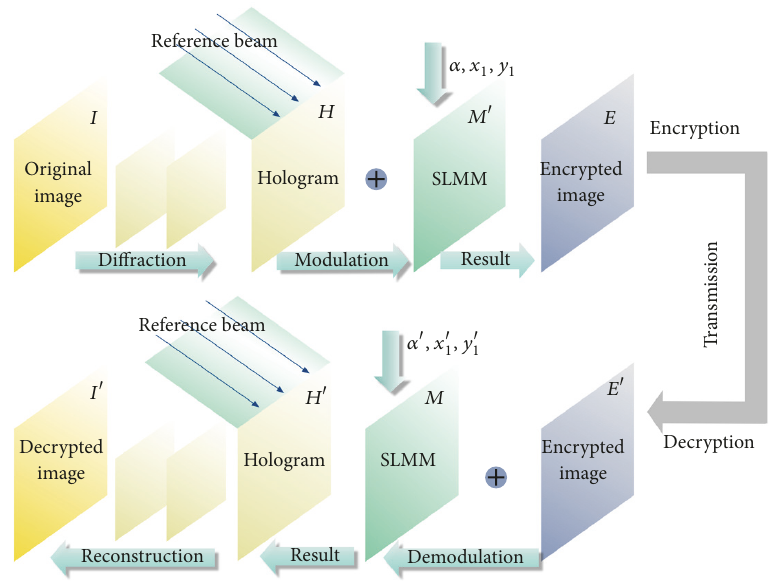
Figure 1: Encryption and decryption process.